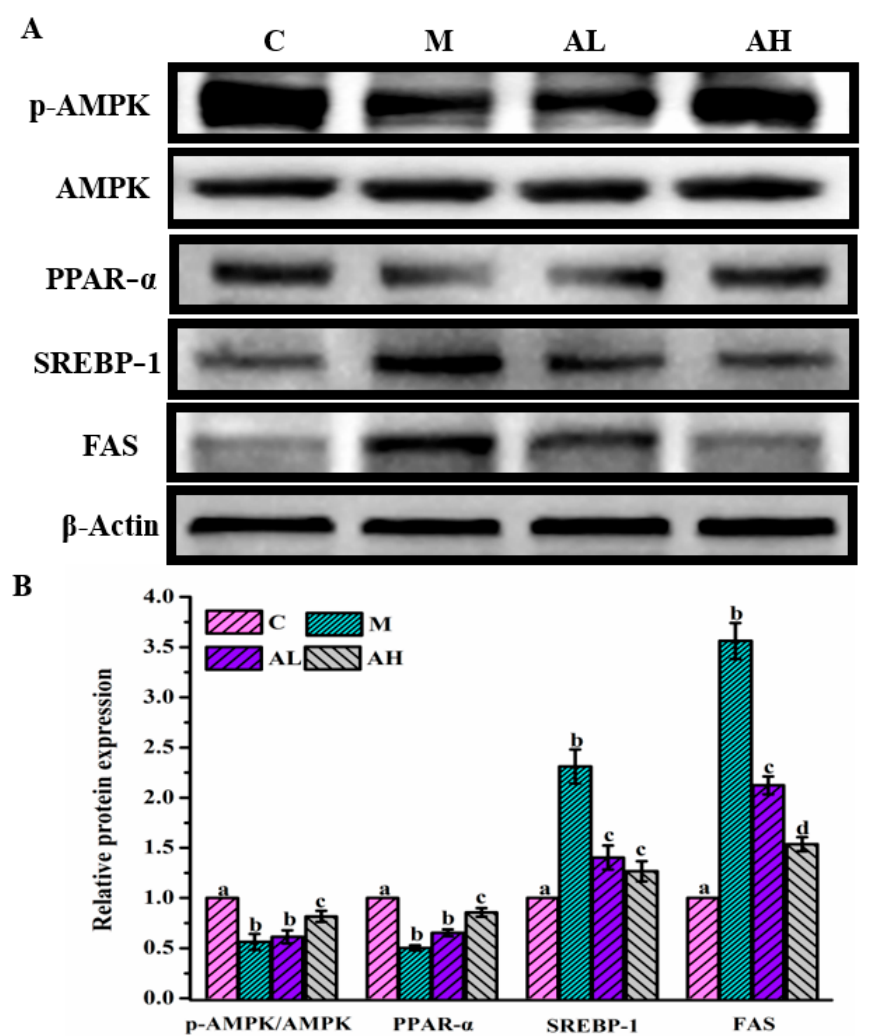
Figure 4. The effect of ethanol extract from R. chinensis Mill. fruits on the expression of several key proteins related to lipid metabolism in the liver, including amp-activated protein kinase (AMPK), phosphorylated amp-activated protein kinase (p-AMPK), peroxidase proliferative receptor- α (PPAR- α ), sterol regulatory element-binding protein1 (SREBP-1), and fatty acid synthase (FAS). ( A ) and ( B ) represent the lipid pathways and the relative quantity of protein, respectively. The relative expressions of above proteins were quantified by normalization with group C and compared with β -actin. C: Control group, M: Model group, AL: Low dose ethanol extract group (200 mg/kg), AH: High dose ethanol extract group (600 mg/kg). Data were expressed as the mean ± SE ( n = 6). Different letters indicate significant differences ( p < 0.05).